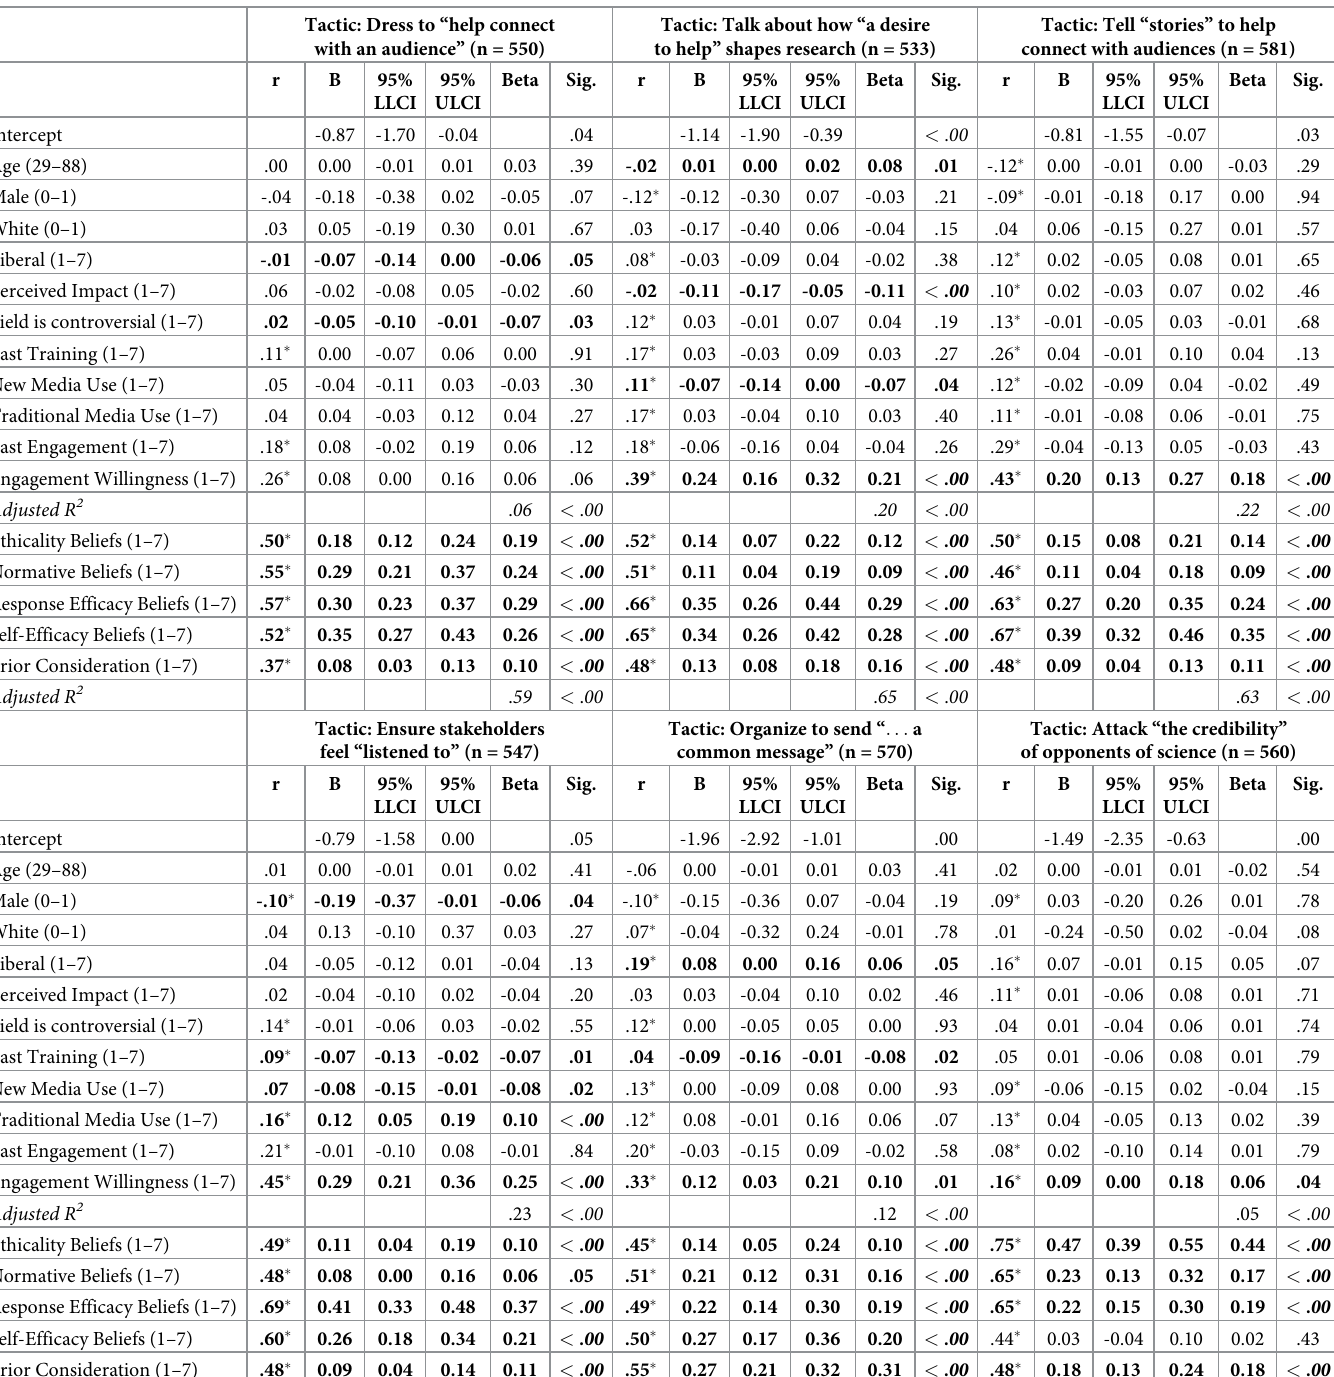
Table 2. Correlations and OLS regression models for willingness to choose a tactic. Tactic: Dress to “help connect with an audience” (n = 550)